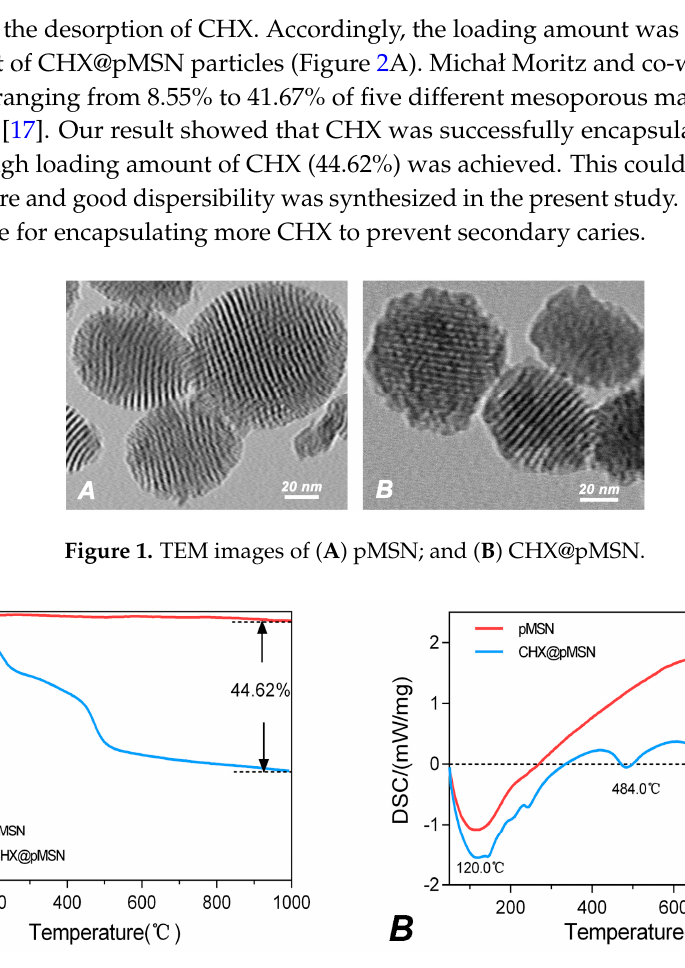
Figure 2. The thermogravimetric analysis for pMSN and CHX@pMSN shows ( A ) TGA curves; and ( B ) DSC curves.